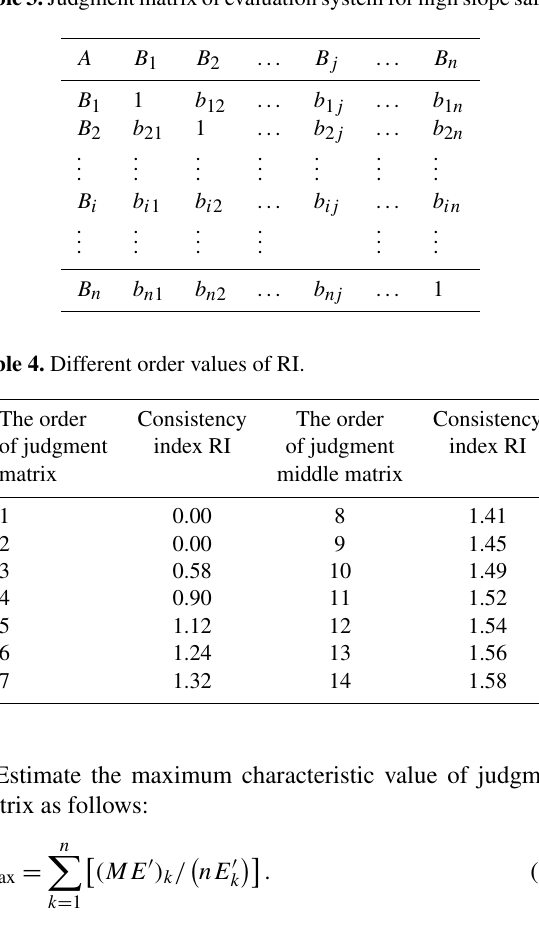
Table 3. Judgment matrix of evaluation system for high slope safety.